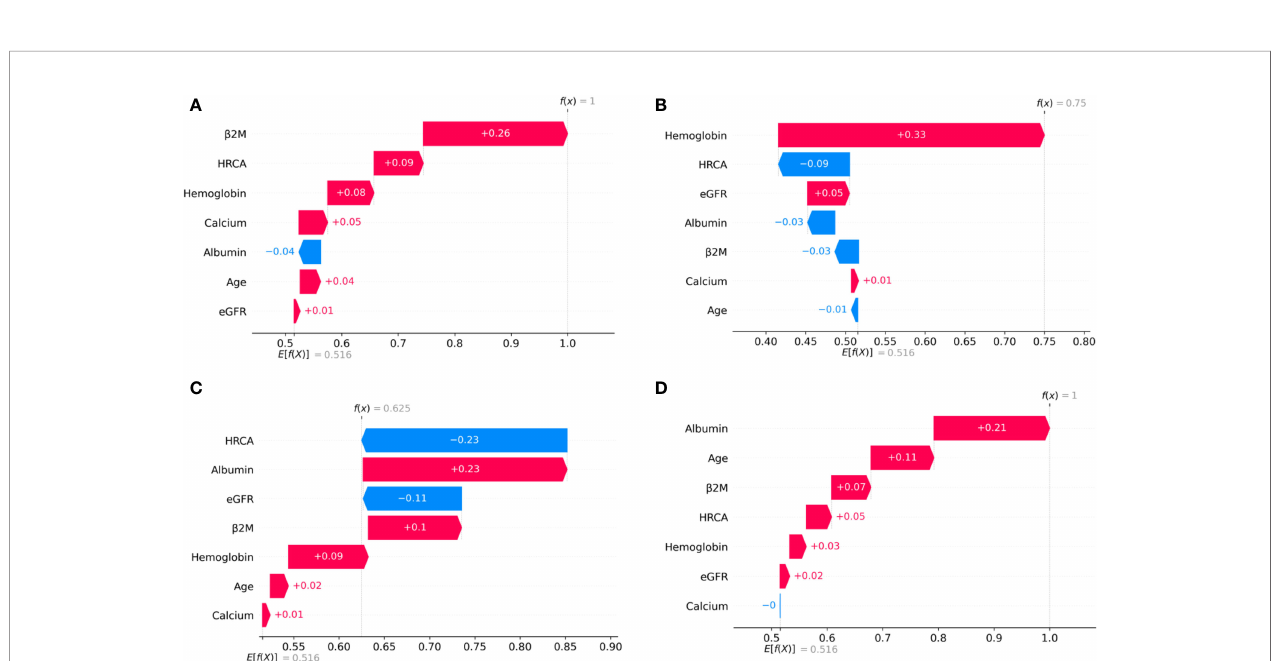
FIGURE 5 | SHAP waterfall plots for the randomly chosen four patients in the intermediate-risk stage (CRSS-2) from the MMIn dataset. The pink color shows the positive impact of the feature, while the blue color shows the negative impact of the feature. Features with a positive impact contributed to the class of intermediate- risk stage prediction, while features with a negative impact contributed to the class opposite to intermediate risk. b 2M, hemoglobin, HRCA, and albumin have the highest overall impact on the intermediate-risk stage prediction in the MMIn dataset. However, the ranking of the features itself differs from patient to patient as can be seen in (A – D) . (A) b 2M has the highest impact followed by HRCA. (B) Hemoglobin has the highest impact followed by HRCA. (C) HRCA has the highest impact followed by albumin. (D) Albumin has the highest impact followed by